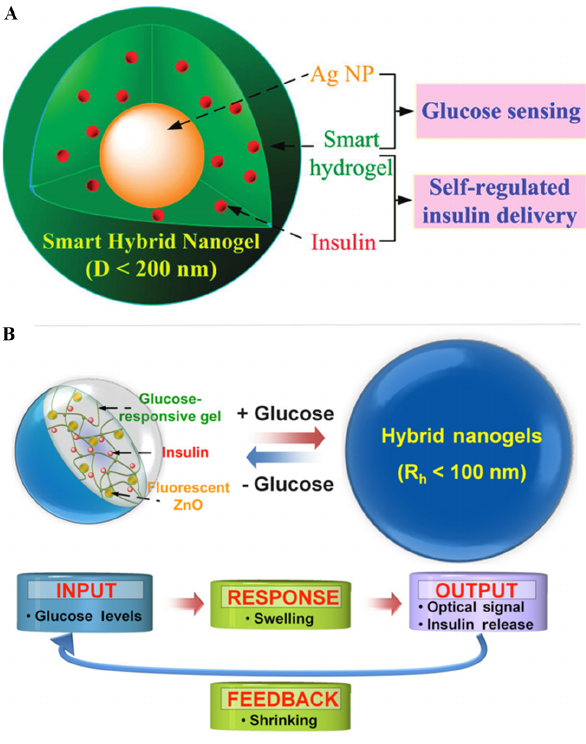
Figure 9: (A) Smart hybrid nanogels for integration of optical glu- cose detection and self-regulated insulin delivery into a single nano-object. Reprinted with permission from [16]. Copyright 2010 American Chemical Society. (B) A single hybrid nanogel for integra- tion of fluorescent glucose sensing and insulin delivery. Reprinted